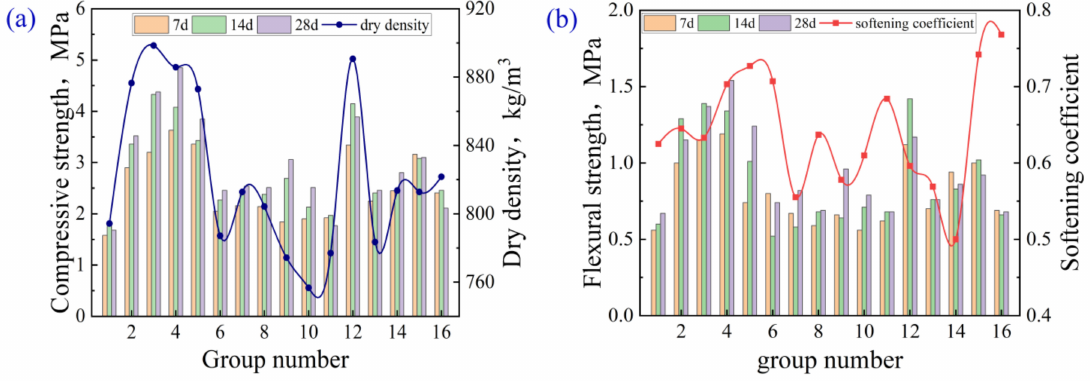
Figure 3. Test results of ( a , b ) orthogonal